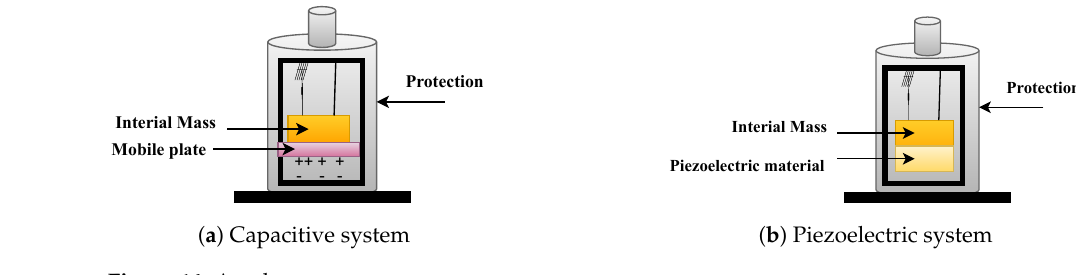
Figure 14. Accelerometer